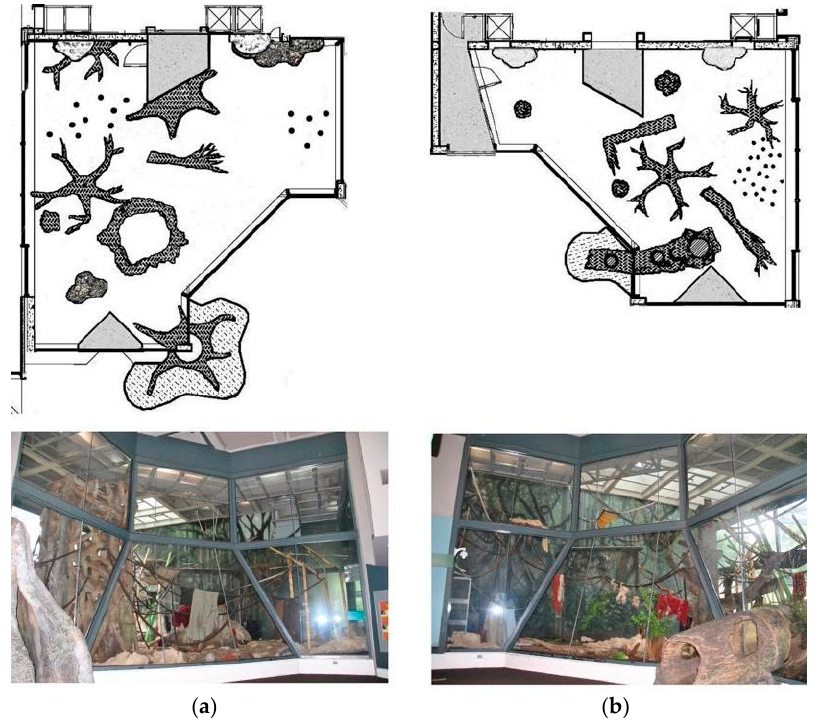
Figure 1. Floor plans and photographs of the two exhibits. ( a ) Exhibit A and ( b ) Exhibit B. Exhibit A has a ground area of 124.5 m 2 and Exhibit B has a ground area of 99.4 m 2 .